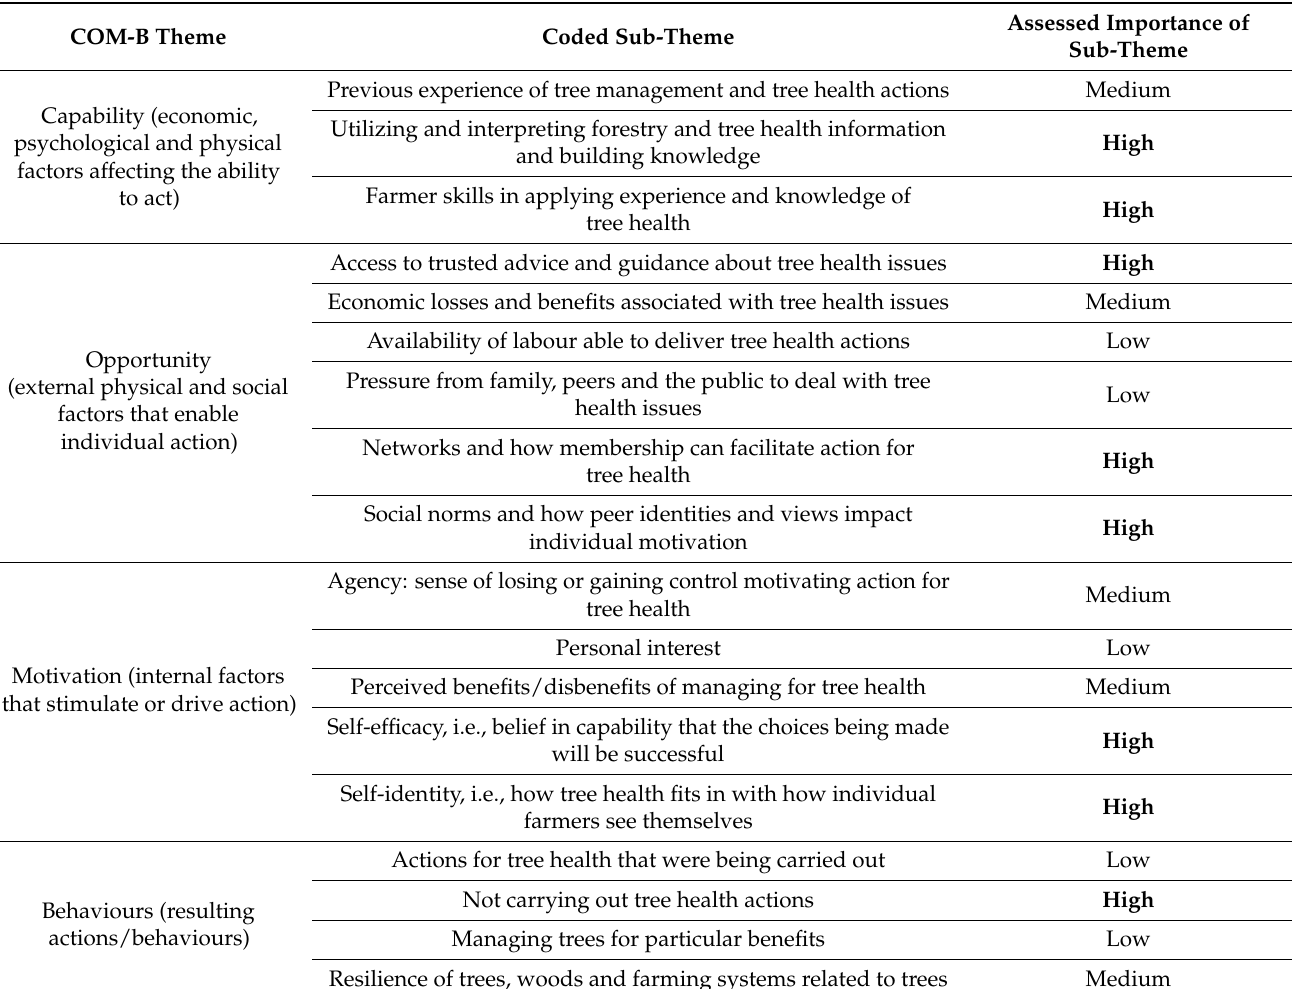
Table 2. Summary of key factors influencing farmer behaviours for tree health, organized by COM-B theme and coded sub-theme, assessed by importance of